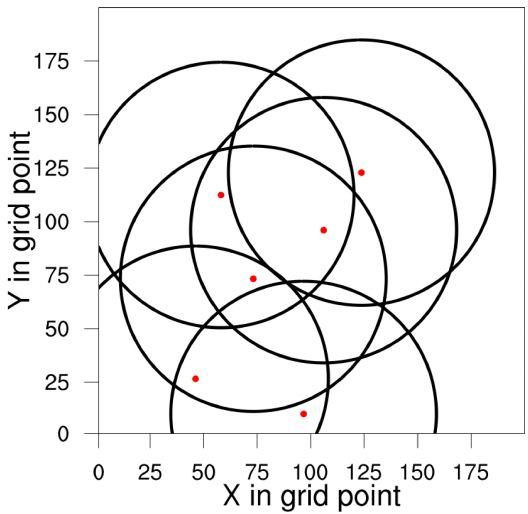
Figure 1. Distribution of the radar network (six radars) expressed by the range of the PPI (plan position indicator) scan at the elevation 0 . 5 ◦